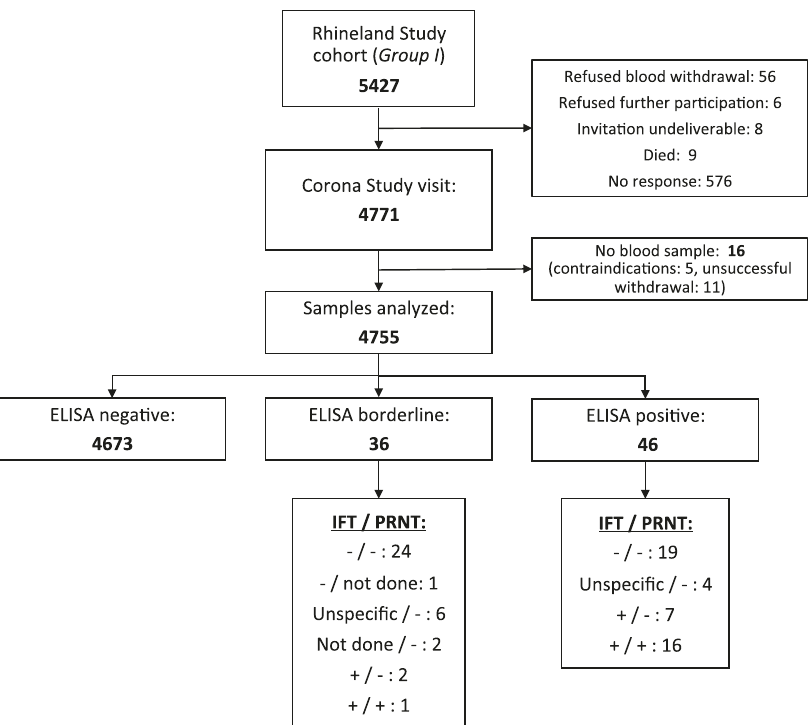
Fig. 1 Flow chart. Overview of the number of participants, their test results as well as reasons for non-participation or missingness. A minus or a plus sign indicates a negative or positive con fi rmatory test result, respectively. IFT immuno fl uorescence test, PRNT plaque reduction neutralization